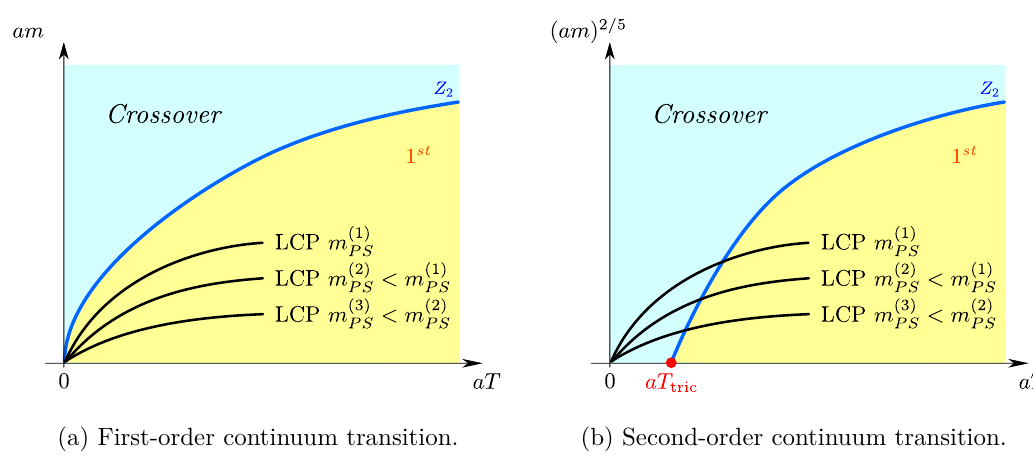
Figure 10. Different scenarios of the approach to the continuum chiral limit along several lines of constant